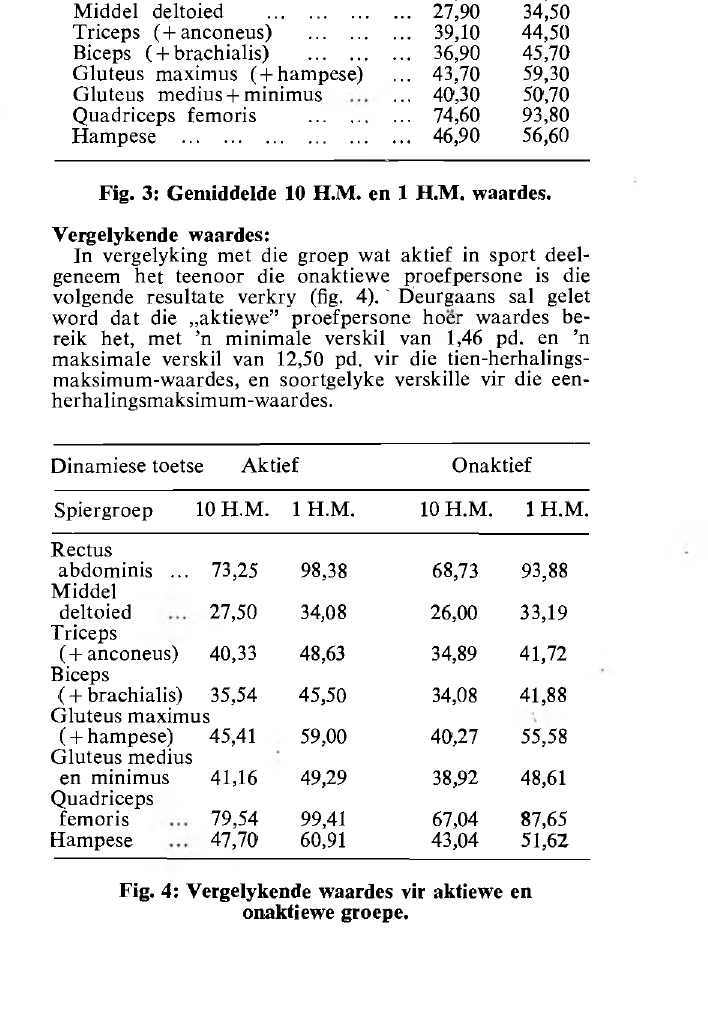
Fig. 4: Vergelykende waardes vir aktiewe en onaktiewe